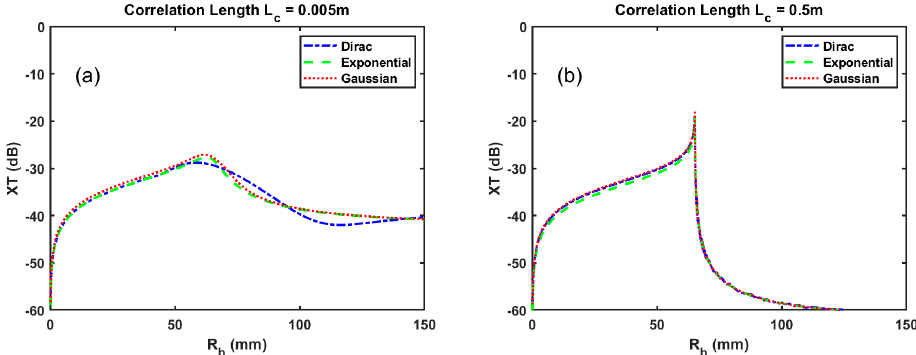
Figure 5. Average crosstalk dependence on the bend radius for correlation length L c = 0.005 m ( a ) and L c = 0.5 m ( b ).